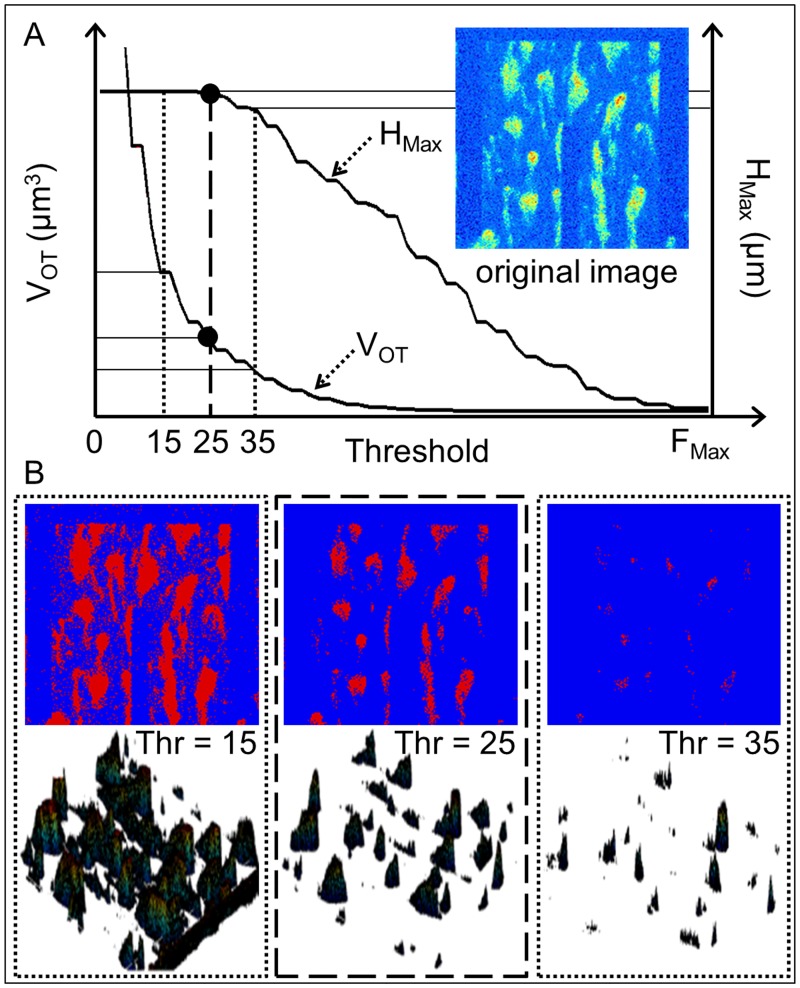
Automatic thresholding for thrombus volume quantification with confocal microscope.A: The optimal threshold is at the elbow point of the volume curve, corresponding to the point of saturation in the height curve (example value: 25). B: Binary mask representation and related 3D volume reconstruction, obtained with absolute threshold 15, 25 and 35, respectively (example values).